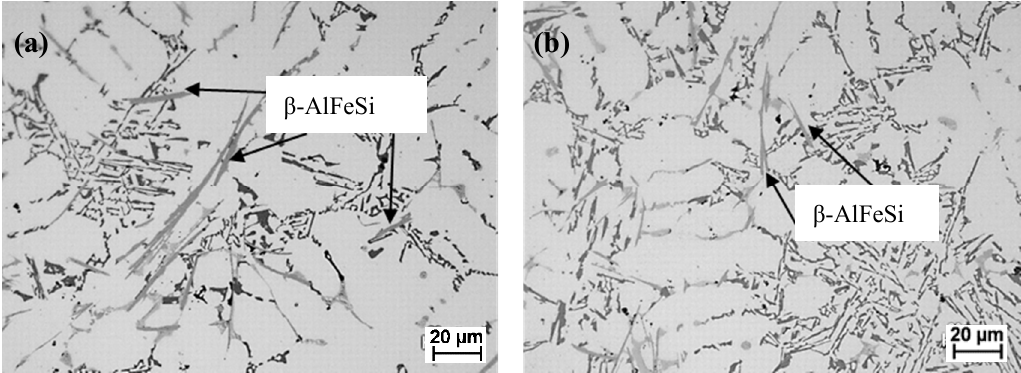
Figure 5. Optical micrographs of aluminum alloy formulated from as-received ingots; ( a ) before de-ironing, and ( b ) after HSMC de-ironing.